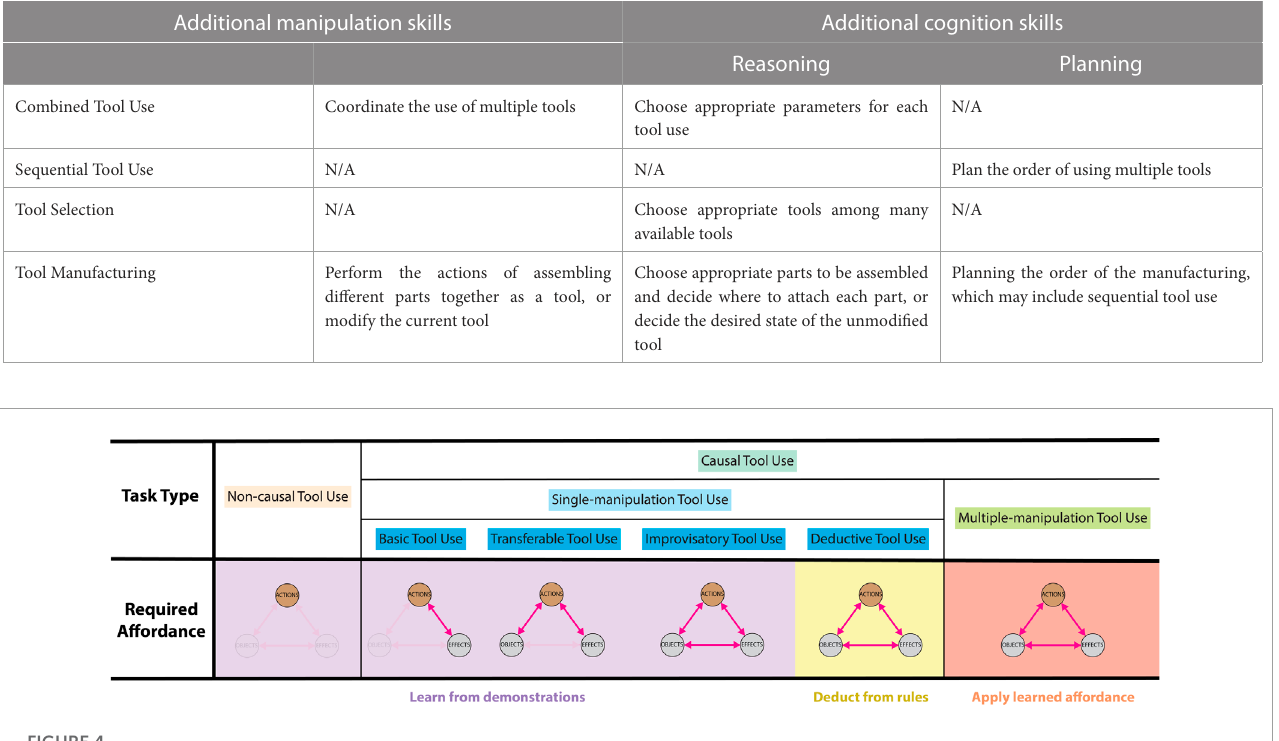
FIGURE 4 The different aspects of tool affordances need to be addressed in the subtype of tool